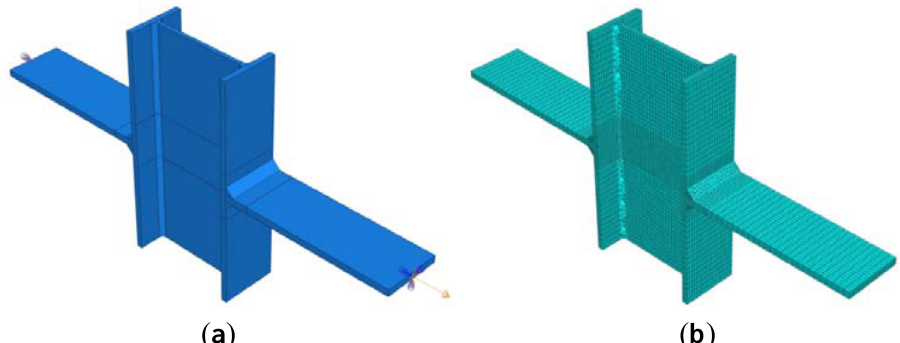
Figure 3. The proposed FE numerical model: ( a ) geometry and ( b ) assigned